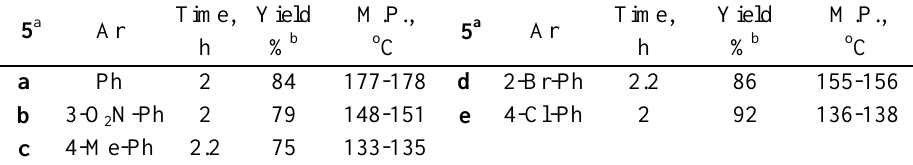
Table 2. Physical constants of the 6-ethoxycarbonyldihydropyrimidinones (